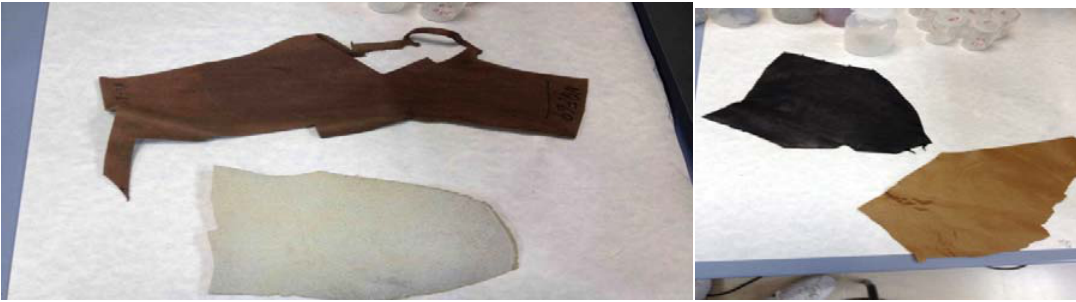
Figure 6. Photos of PT1 and PT5 (processed leather